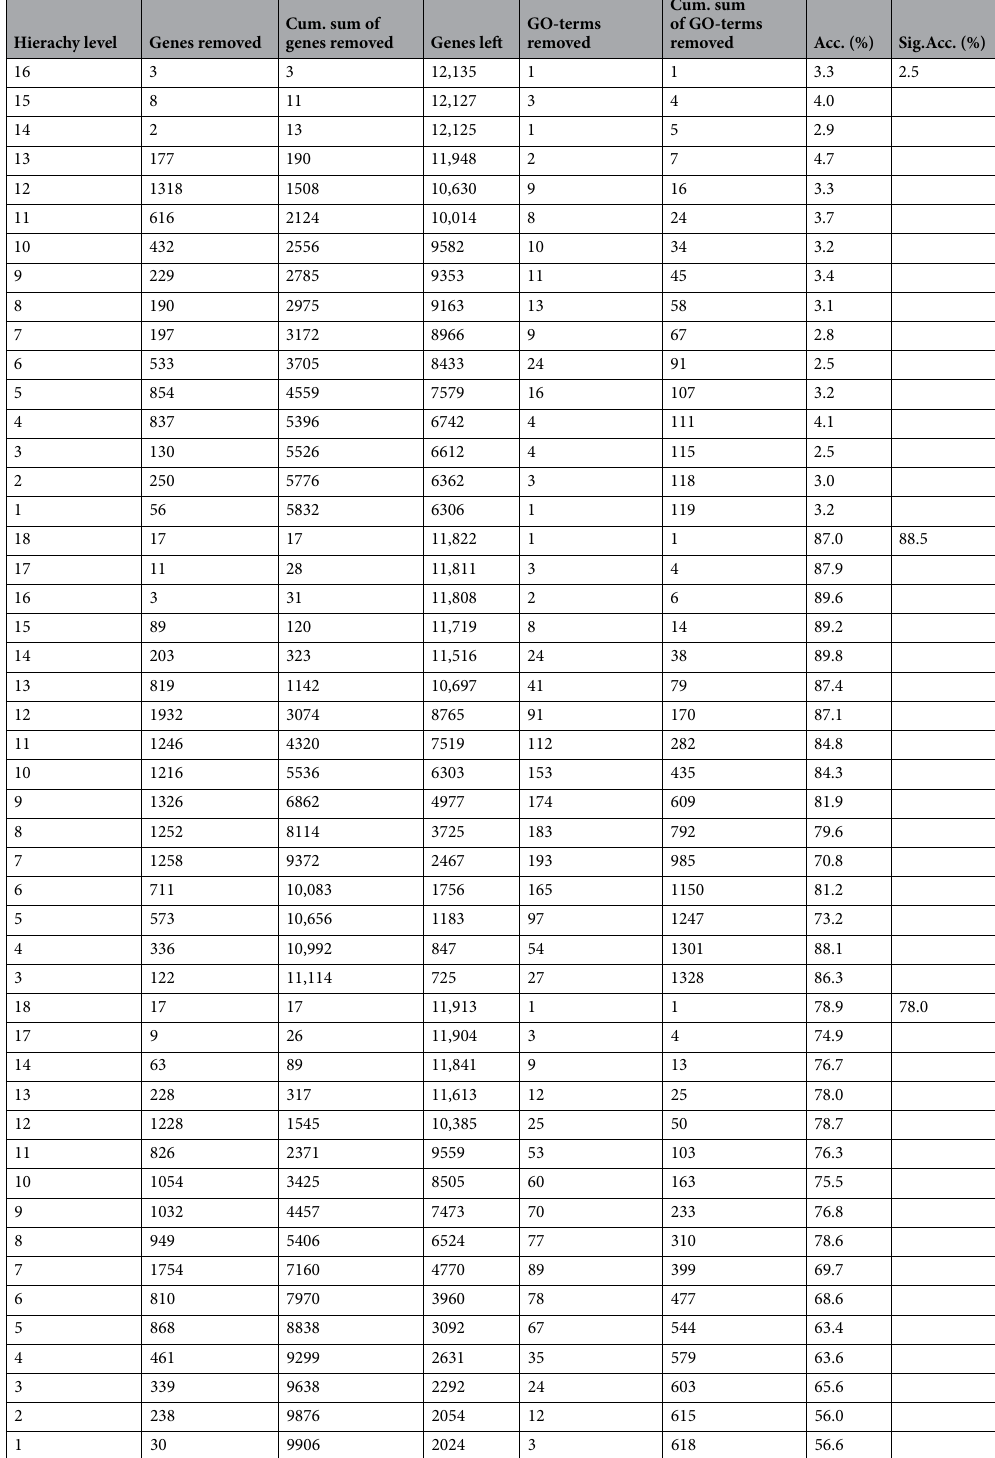
Table 1. Results for GRP 2 (NKI data) for three signatures. Top: Pei. Middle: Chang. Bottom: Wong– Mitochon. The p-values have been Bonferroni